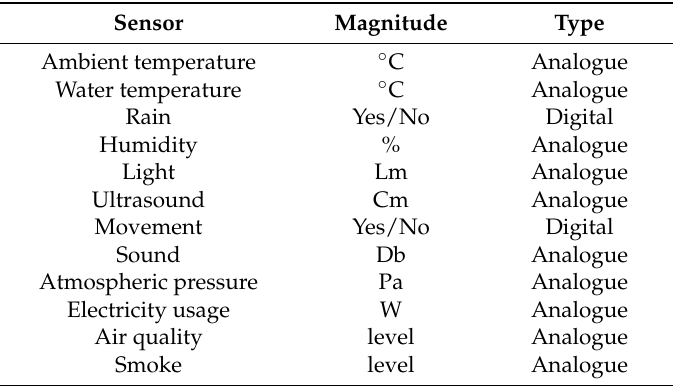
Table 1. Sensors